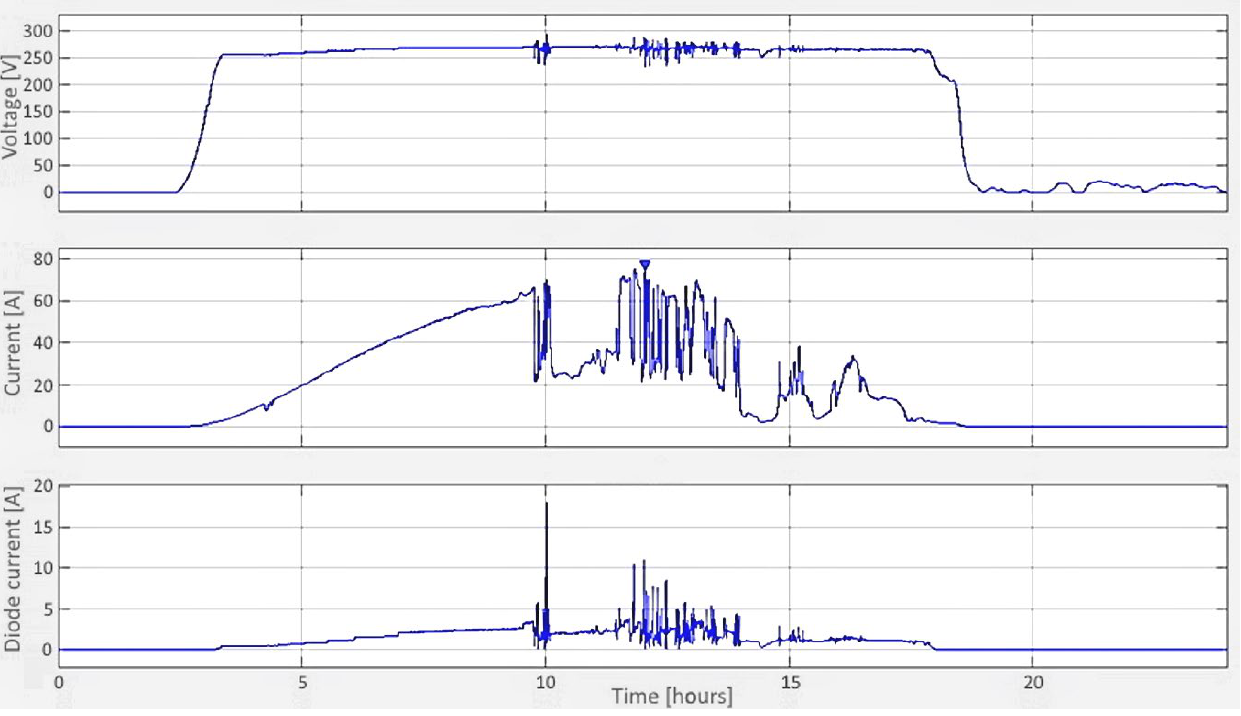
Figure 21. Daily waveforms of voltage and current of the PV modules (19.825 kW) and PV diode current on a sample day in July. Table 3. Values of voltage and current on PV modules (19.825 kW) and PV diode current on a sam- ple day in July.